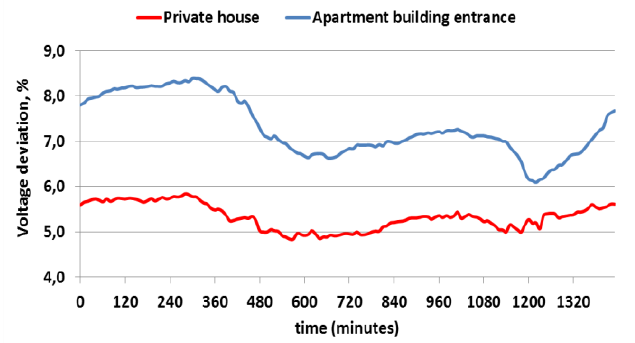
Fig. 1 - Change of a deviation of voltage on input of an apartment house and private house Table 1 - Estimated data for minimizing the